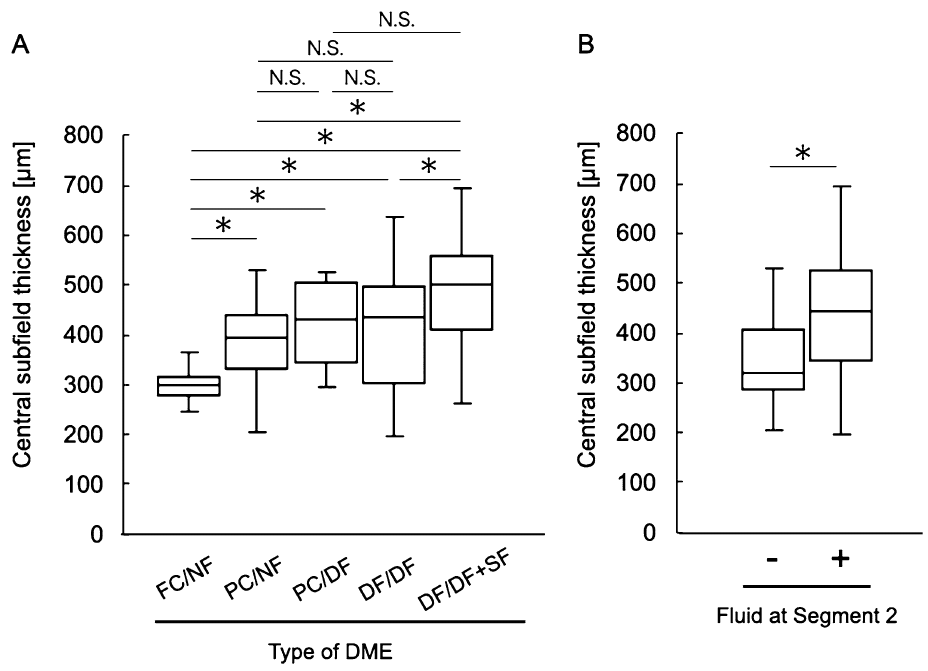
Figure 8. Relationship between the central subfield thickness (CST) and the en face image-based classification of diabetic macular edema (DME). ( A ) CST values are compared among the DME types. ( B ) CST values compared according to the presence or absence of fluid at Segment 2. DME diabetic macular edema, FC/NF foveal cystoid space/no fluid type, PC/NF parafoveal cystoid space/no fluid type, PC/DF parafoveal